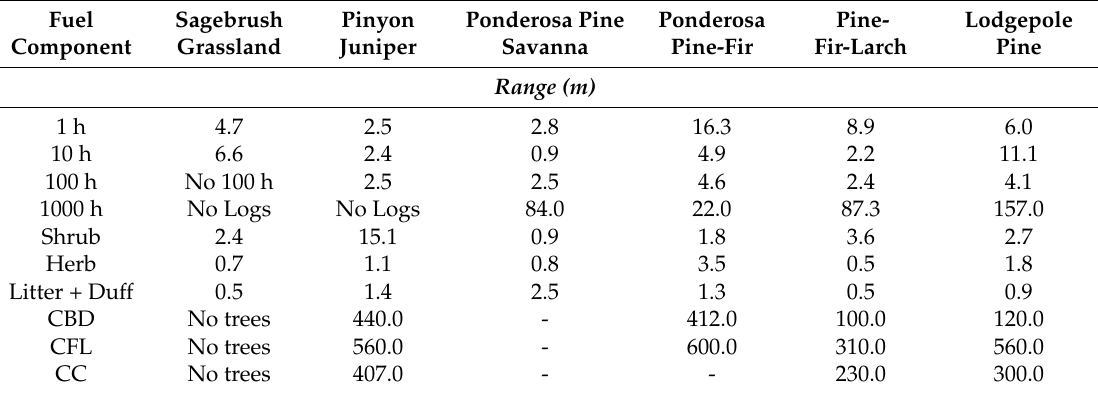
Table 2. Semi-variogram range statistics for all surface fuel components and three canopy fuel variables across the six FUELVAR sites. Empty cells indicate no spatial model could be fit to the data.